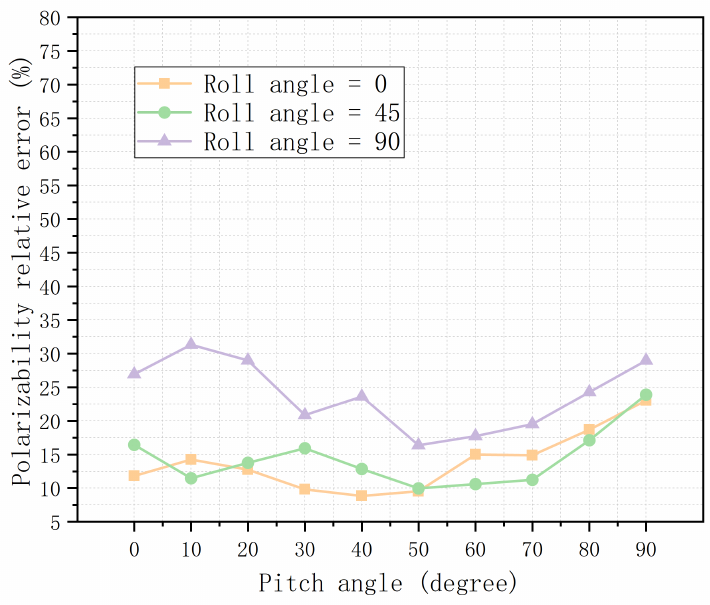
Figure 13. Error of the polarizability error of the IVE-KF algorithm at different posture